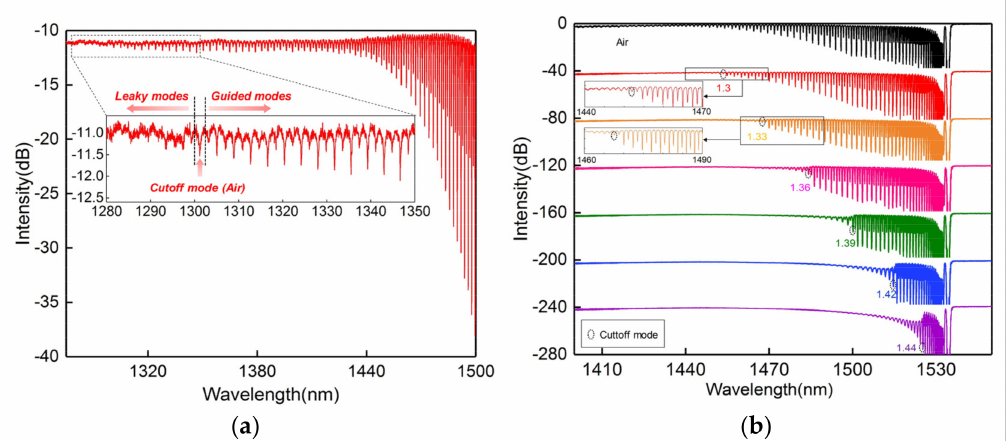
Figure 8. ( a ) Transmission in the air (e ff ective refractive index (RI) ~ 1000); ( b ) spectral responses to di ff erent RI solutions; inset: magnified spectrum around the cuto ff